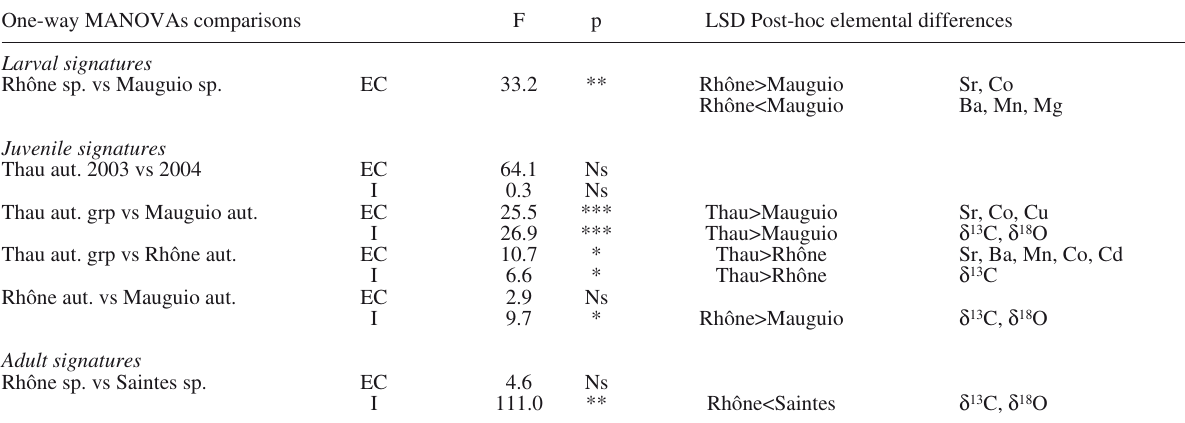
Adult signatures Rhône sp. vs Saintes sp.